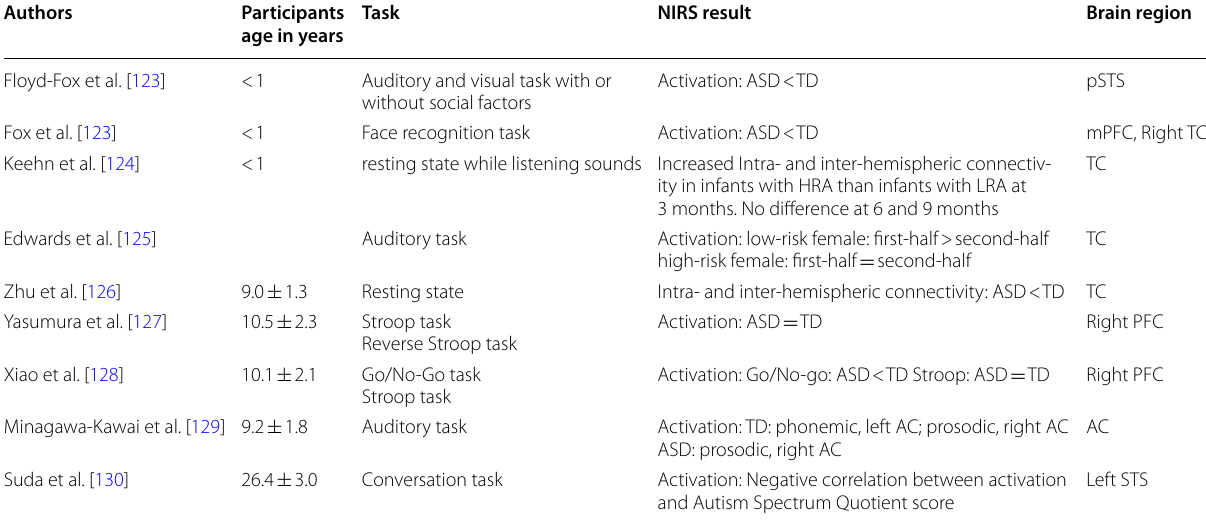
The studies were ordered by ages of individuals with ASD PFC prefrontal cortex, mPFC medial prefrontal cortex, TC temporal cortex, STS superior temporal sulcus, pSTS posterior superior temporal sulcus, AC auditory